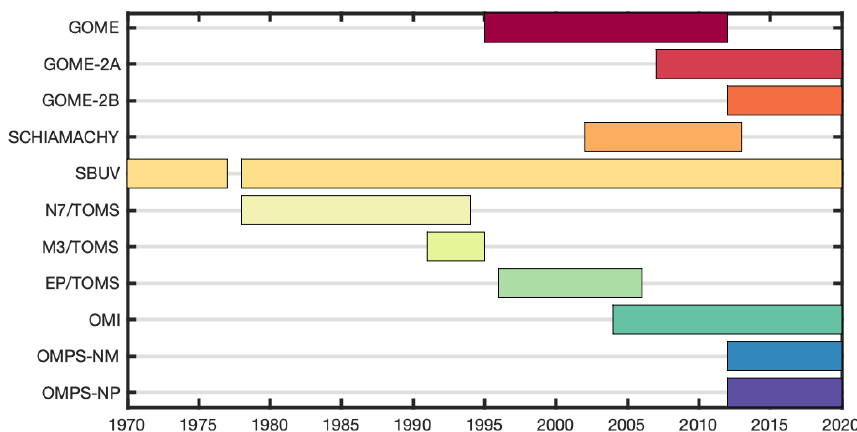
Figure 2. Timeline showing years with available measurements from each satellite instrument considered for filling the gaps of the Halley Dobson total ozone